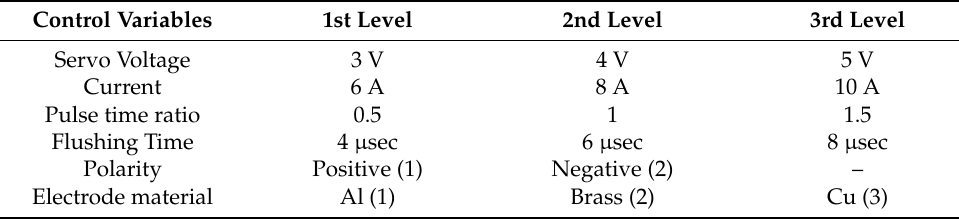
Table 3. Input Parameters and their values.